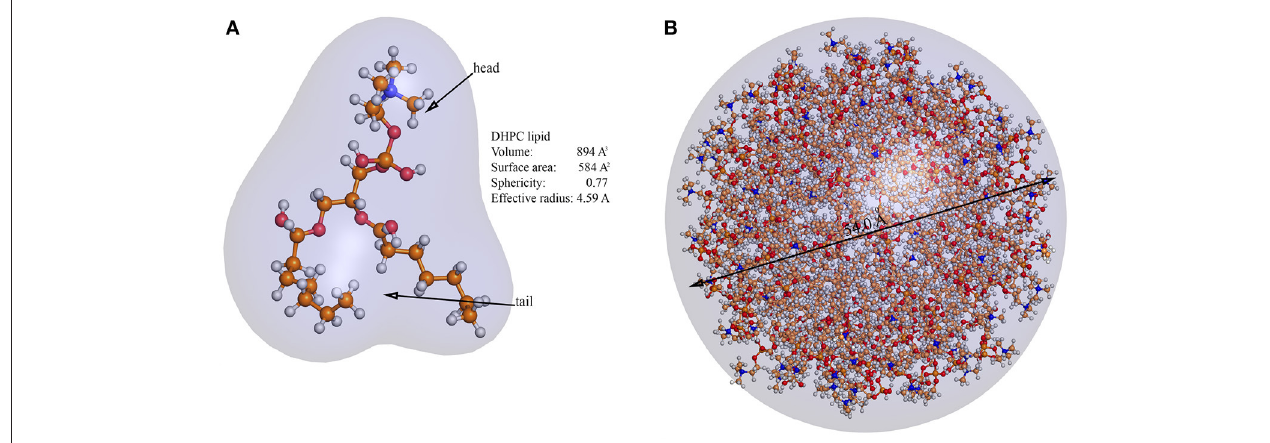
FIGURE 5 | All atom simulation of DHPC micelle. (A) The figure shows a geometry of the DHPC surfactant molecule used in simulation and gives parametric description of volume, surface area, sphericity, and effective radius. (B) Indicates atomistic simulation result contoured by Gaussian map and the diameter of the micelle, measured by PyMol. The diameter of the simulated micelle appears to be 54.0Å with the uncertainty of the measurement